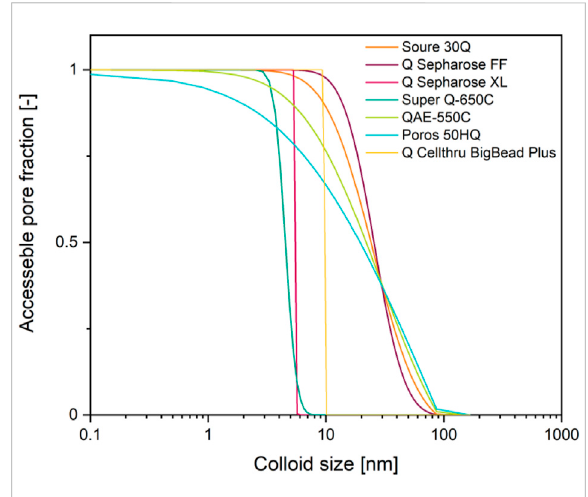
FIGURE 3 Accessible pore fraction as a function of colloid size and depending on the pore size distribution of common anion exchange resins. Pore size distribution data (Yao and Lenhoff 2006) were used to build a cumulative sum and then normalized using the highest